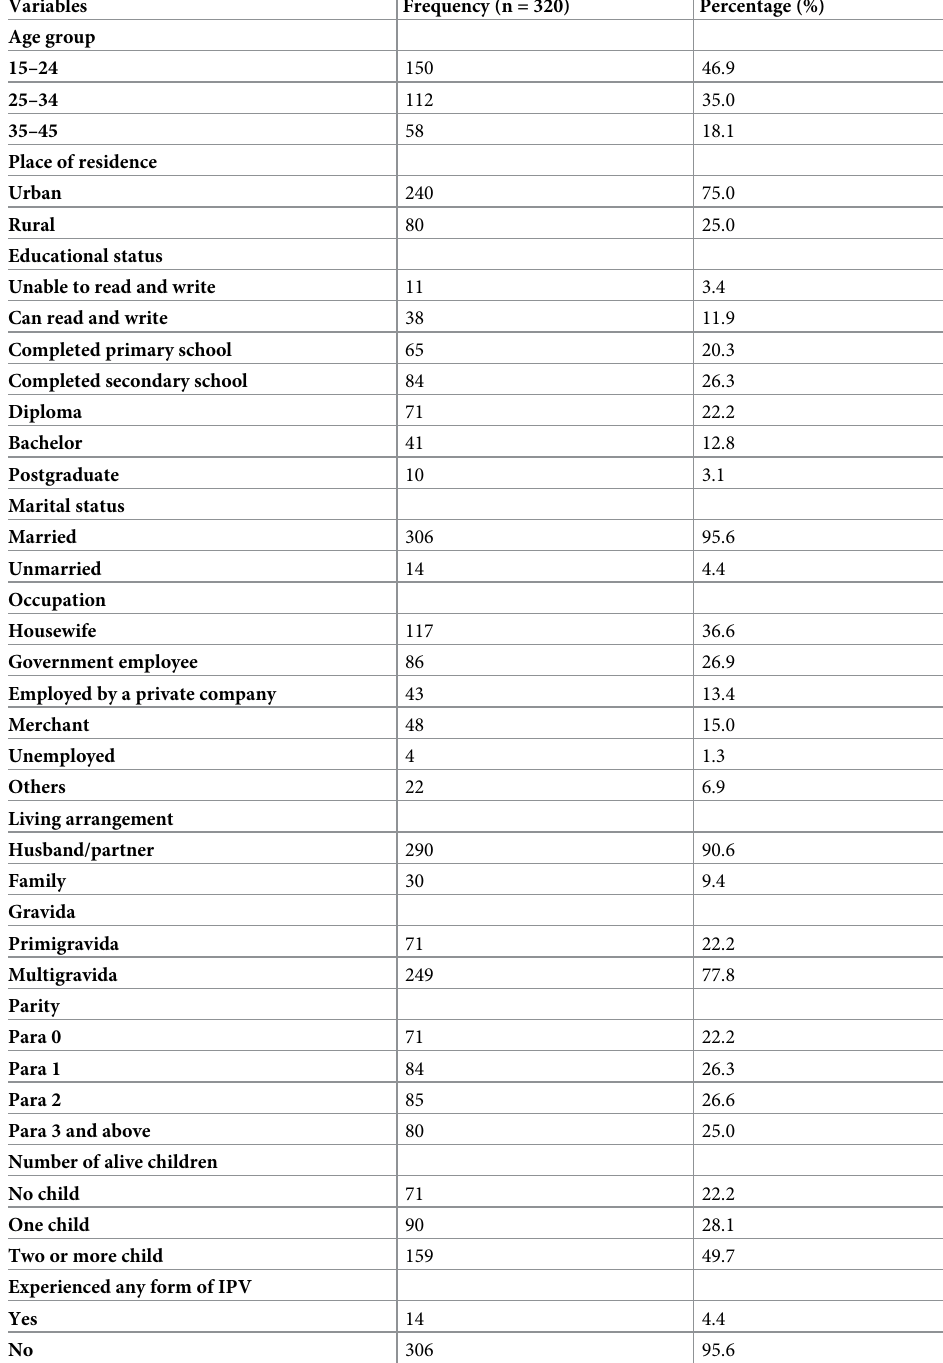
Table 1. Baseline characteristics of the pregnant women seeking antenatal service at public health care facilities in Arbaminch and Birbir towns,